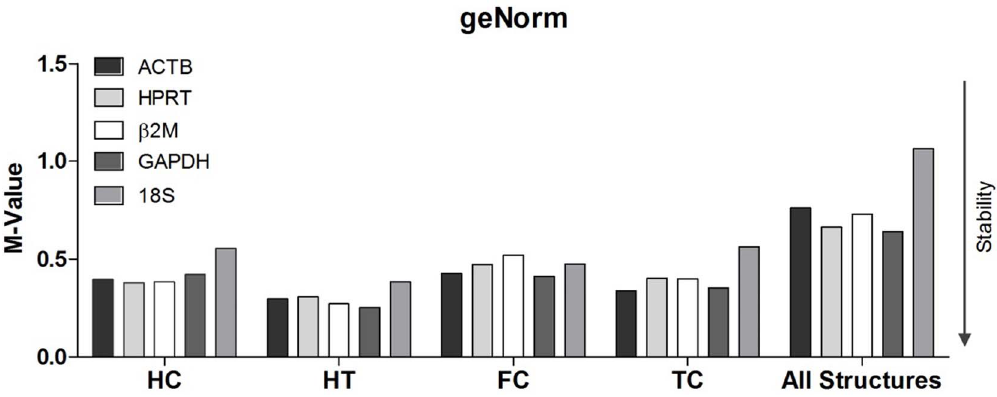
Figure 2. geNorm stability analysis. Evaluation of gene expression stability by geNorm for individual brain regions. All HKG candidates presented values that were lower than the cut-off value (1.5). HC, hippocampus; HT, hypothalamus; FC, frontal cortex; TC, temporal